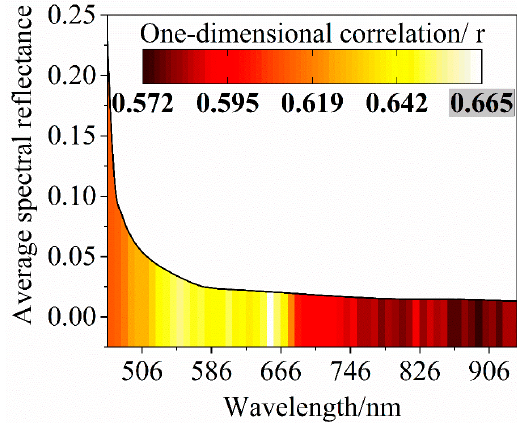
Figure 10. One-dimensional r diagram between SMC and 0.5-order absorbance spectrum.